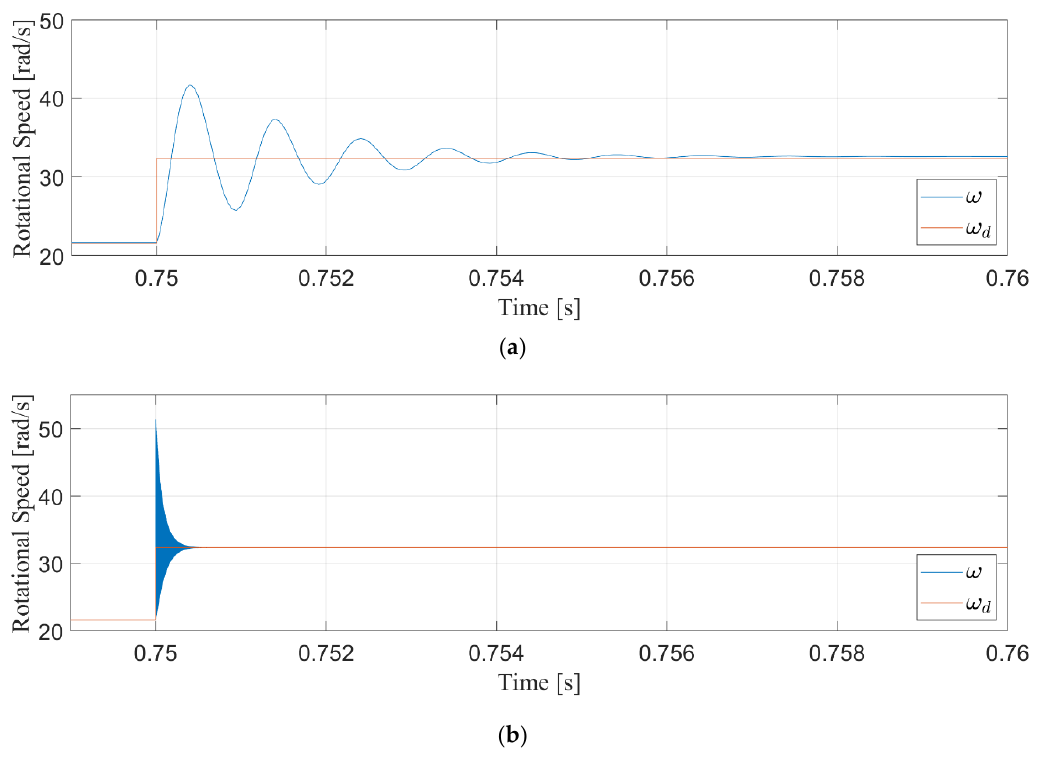
Figure 3. Step response of linear controller ( a ) and nonlinear controller ( b ) from change in wind speed. Table 4. Settling time of linear and nonlinear controllers after wind step